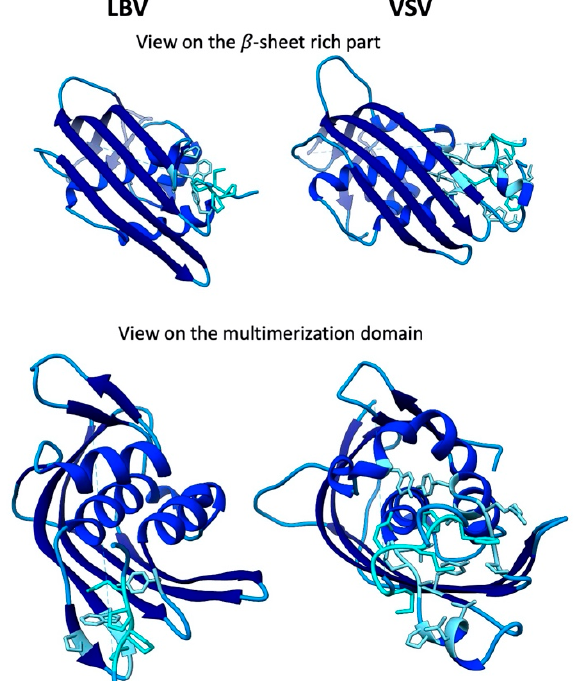
Figure 3. Comparison of the structure of the Lagos bat virus (LBV) (pdb 2w2s) and VSV (pdb 2w2r) M-proteins [3]. Residues involved in the interaction between the M-proteins are depicted in cyan on the N-terminal fragment and in light blue on the C-terminus.